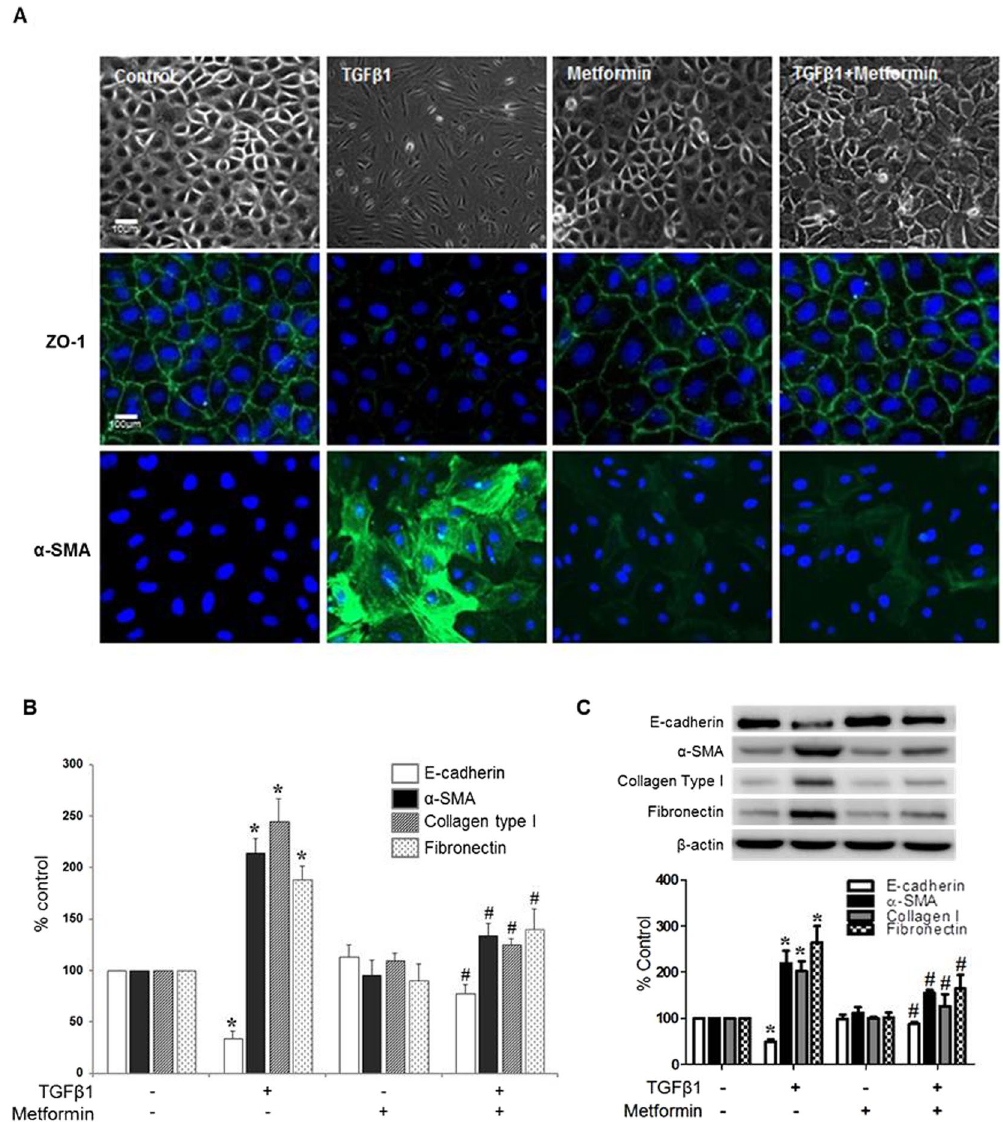
Figure 1. Effect of Metformin on TGF- β -induced EMT. TGF- β 1 (1 ng/mL) induces the morphologic changes of HPMCs from a cuboidal, cobble-stone appearance to elongated, fibroblastoid morphology with decreased expression of ZO-1 and the acquisition of α -SMA expression in HPMCs. ( B , C ) Real-time PCR ( B ) and western blot analysis ( C ) reveal a decreased E-cadherin expression with an increase in α -SMA, collagen type I and fibronectin by TGF- β 1. Metformin significantly ameliorates TGF- β 1-induced EMT ( A – C ). Representative cell morphology and fluorescein immunocytochemistry for ZO-1 (green) and α -SMA (green) with nuclear DAPI staining (blue) at 48 hours of TGF- β 1 with or without metformin ( A ). Quantitation bars for real-time PCR ( B , n = 5) and representative western blots with quantitation bars ( C , n = 6) are shown. * p < 0.05 vs. others, # p < 0.05 vs. TGF- β